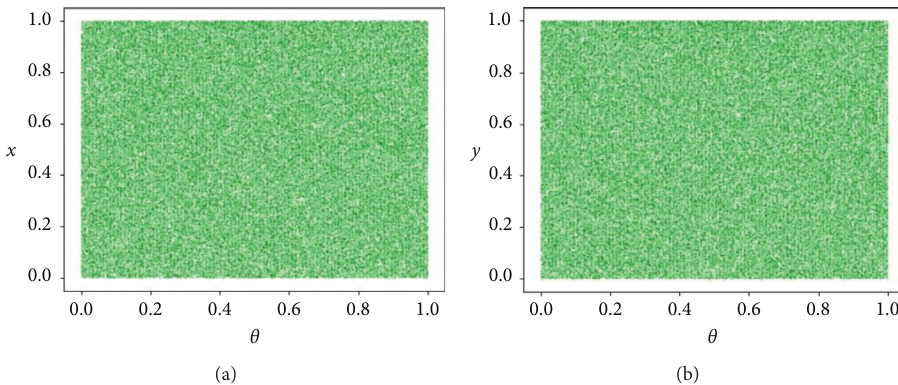
Figure 2: The bifurcation diagram of N2D-LSCM. (a) θ − x ; (b) θ − y